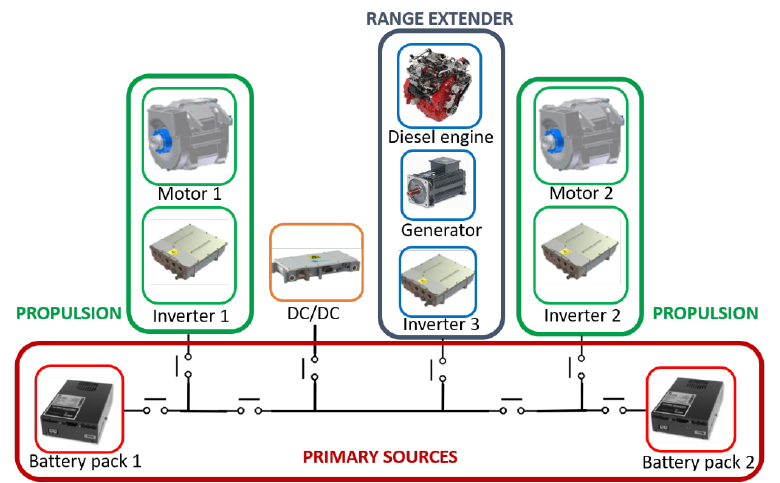
Figure 10. Powertrain